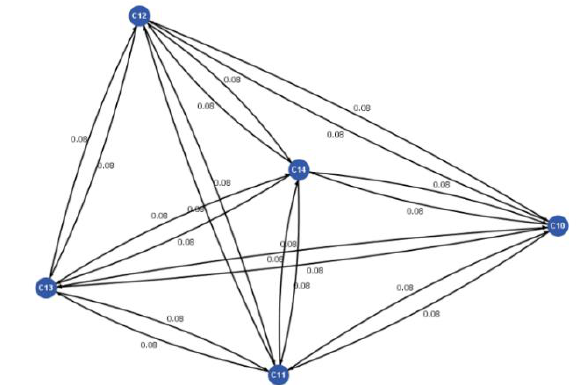
Fig. 13. Graphical representation of E & H factors of FCM.